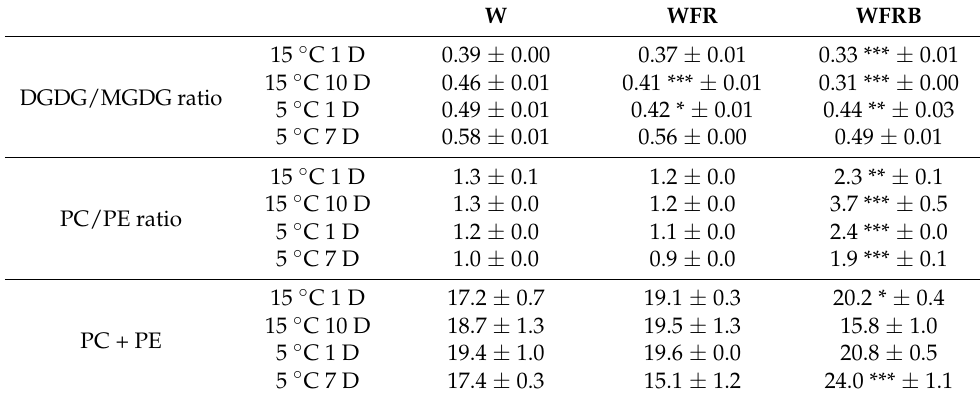
Table 1. Changes in the DGDG/MGDG and PC/PE ratios in barley after supplementary FR and Blue light treatments at different temperatures. The signals were expressed as a percentage of the total lipid content detected (total lipid signal percentage (%)). In all cases, the treatments were compared to the first-day samples in the control W-lighted zones (15 ◦ C 1 D). The samples were illuminated with white light, white light supplemented with far-red light (WFR) or combined far-red with additional blue light (WFRB). In addition to light treatment, 5 ◦ C treatments were also made. The samples were taken on the first and last days of the treatment, which was ten days at 15 ◦ C and seven days at 5 ◦ C. In all cases, the leaf samples were cut from the central part of the second youngest leaf. Statistical analysis was performed with multiple-way ANOVA followed by Dunnett’s post-hoc test. Measurements were made on 3 to 5 independent biological replicates ( ± SE). Significance levels are indicated by * p < 0.1 and ** p < 0.05 and *** p < 0.01. W WFR